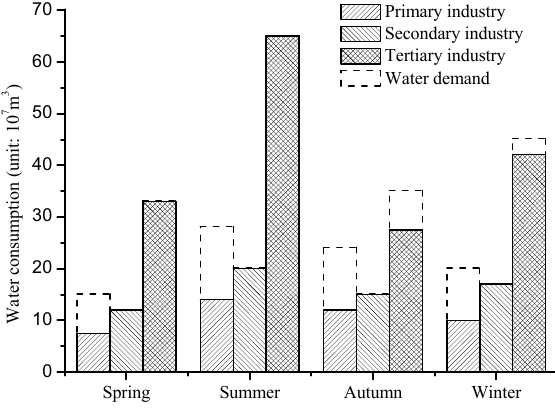
Figure 3. Water consumption of various sectors under violating constraint α = 0.10.